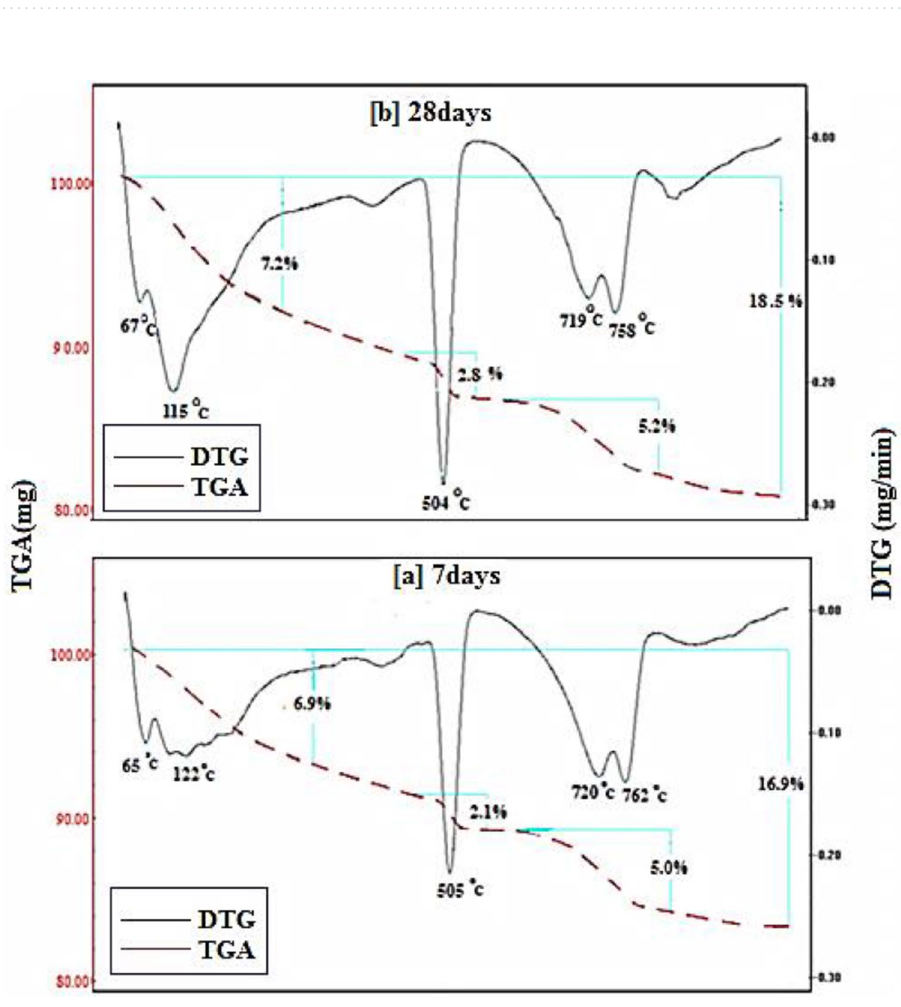
Figure 15. TGA/DTG thermograms of hardened specimens made from mix A at ( a ) 7 days and ( b ) 28 days